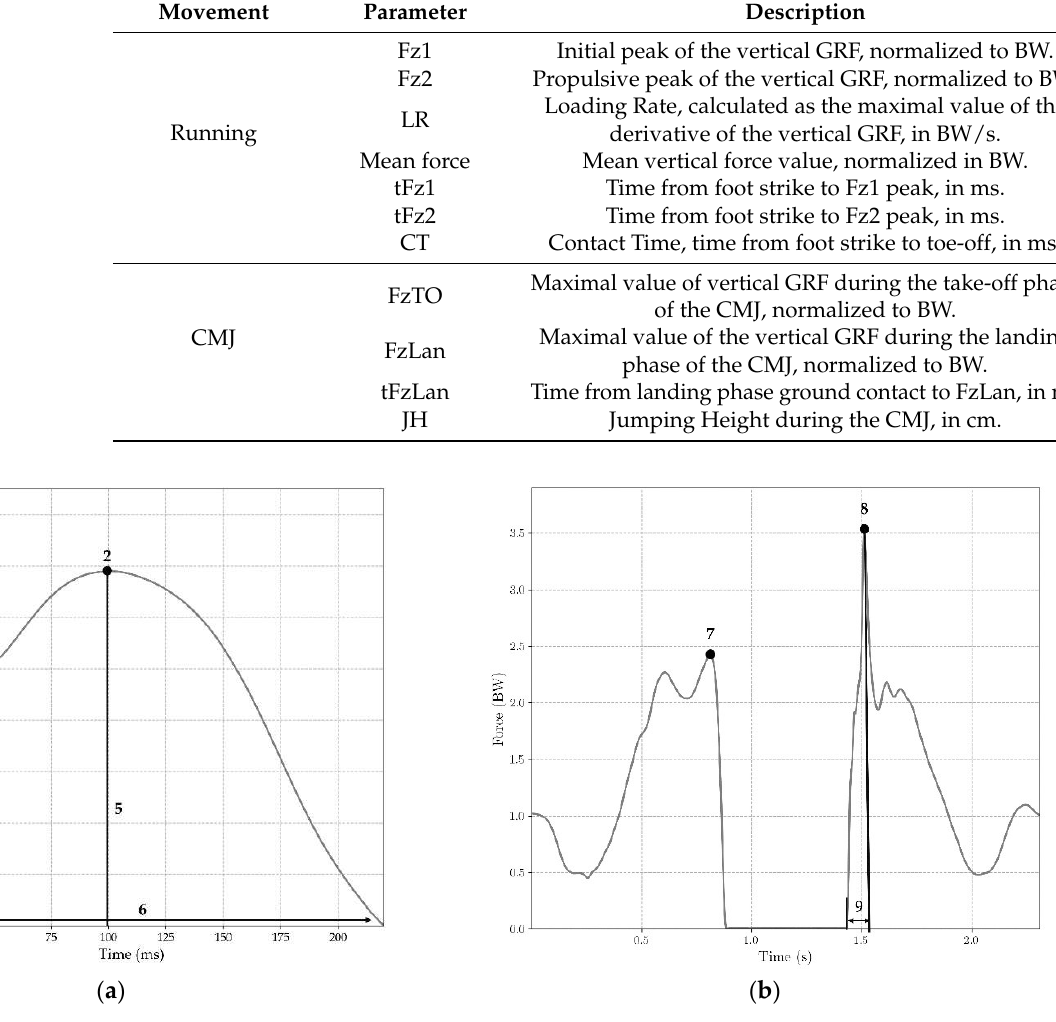
Figure 5. ( a ) Parameters measured for typical running movements: 1 = Fz1, 2 = Fz2, 3 = LR, 4 = tFz1, 5 = tFz2, 6 = CT; ( b ) Parameters measured for CMJs: 7 = FzTO, 8 = FzLan, 9 = tFzLan.